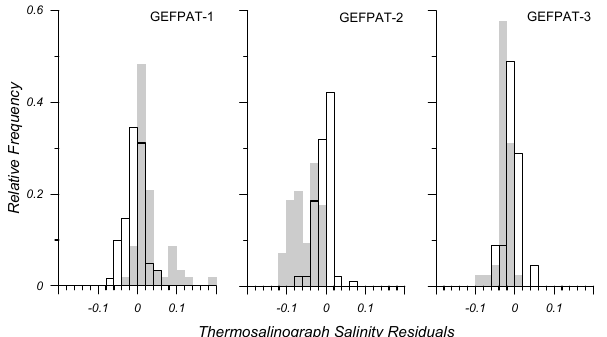
Figure 4. Relative frequency distribution of salinity residuals be- fore (shaded grey) and after (black solid line) thermosalinograph calibration for GEF Patagonia